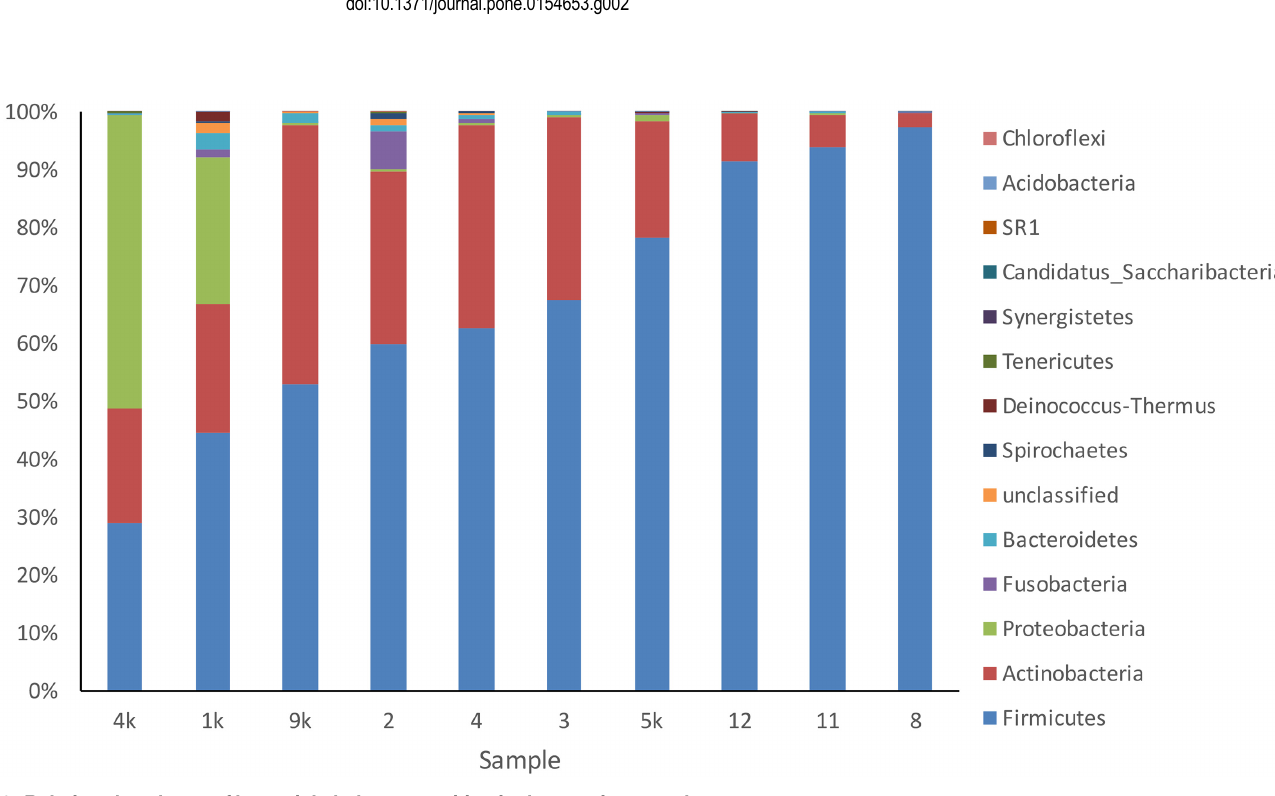
Fig 3. Relative abundance of bacterial phyla composition in deep caries